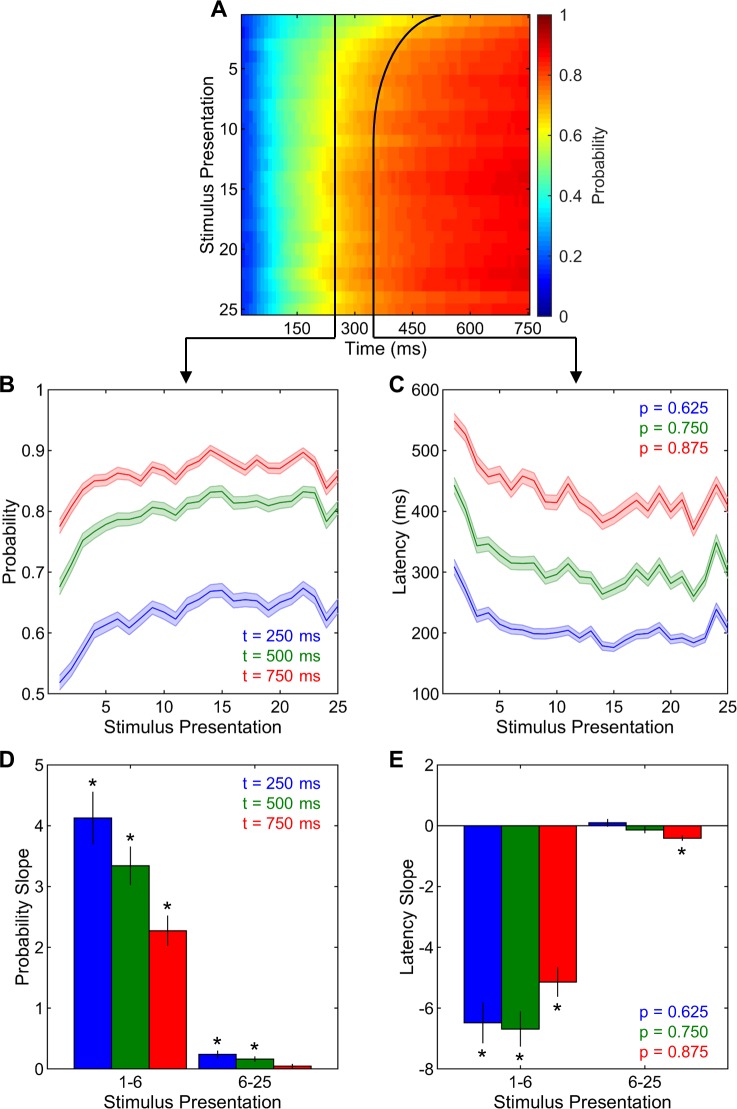
Neural decoding.(A) Neural decoding accuracies were analyzed as the probability of correct decoding across time points along the stimulus duration and stimulus presentations. The black arrows schematically indicate the subsequent time point (left) and probability level (right) analyses. (B) Correct neural decoding probabilities at all selected time points increased with stimulus presentations. (C) Correct neural decoding latencies at all selected probability levels decreased with stimulus presentations. (D) The slopes of correct neural decoding probabilities were higher than zero at all time points for presentations 1–6 and at the 250 and 500-ms time points for presentations 6–25. (E) The slopes of correct neural decoding latencies were lower than zero at all probability levels for presentations 1–6 and at the 0.875 probability level for presentations 6–25. Shadings and error bars indicate SEMs. Asterisks denote significant differences from zero.